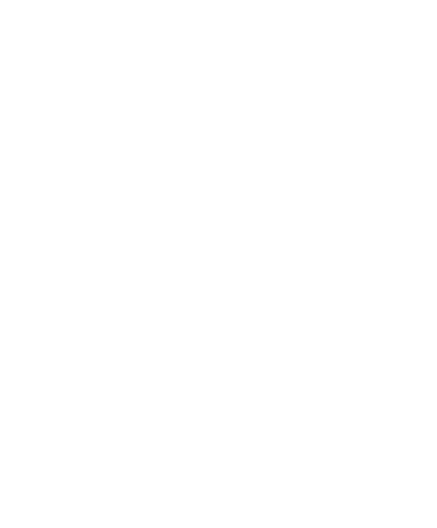
Figure 22. MAA measurement procedure of the unit